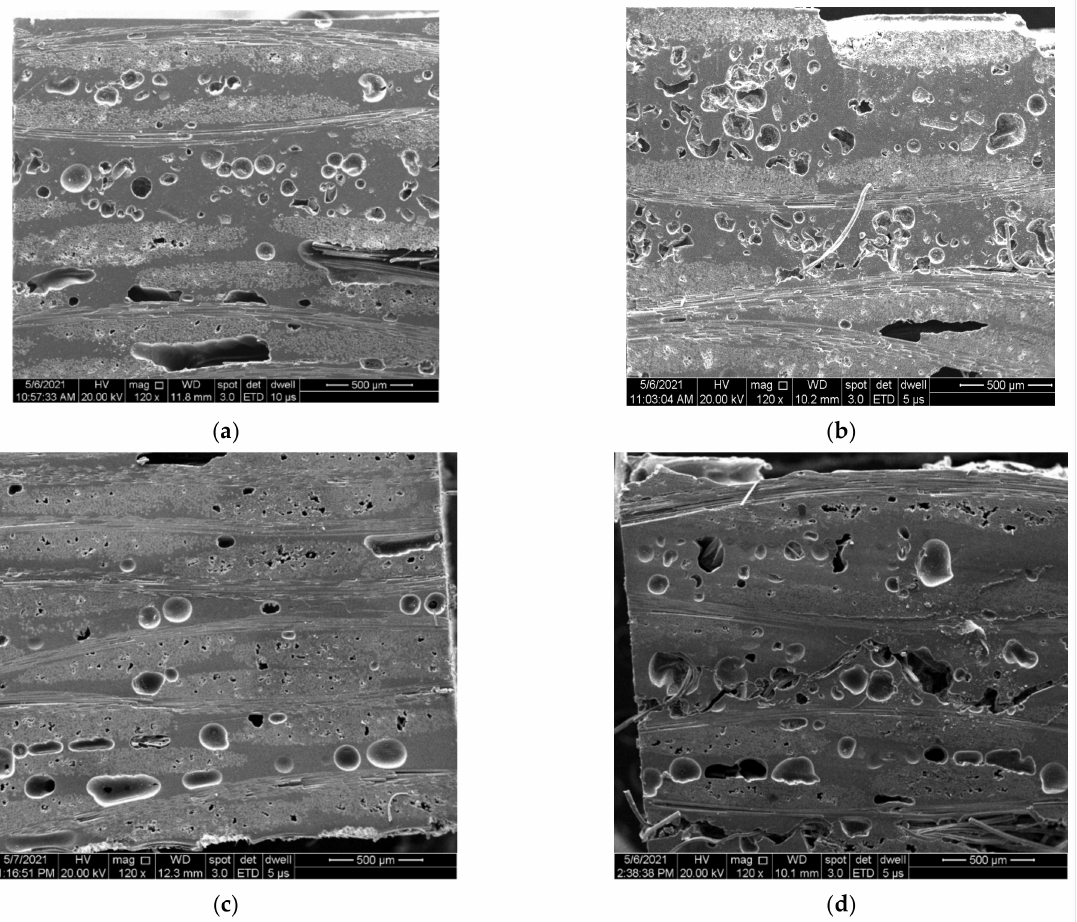
Figure 12. Representative SEM micrographs at 500 µ m from impacted samples for ( a ) DCPD sample with 5% microcapsules; ( b ) DCPD sample with 15% microcapsules; ( c ) ENB sample with 5% microcapsules; ( d ) ENB sample with 15%